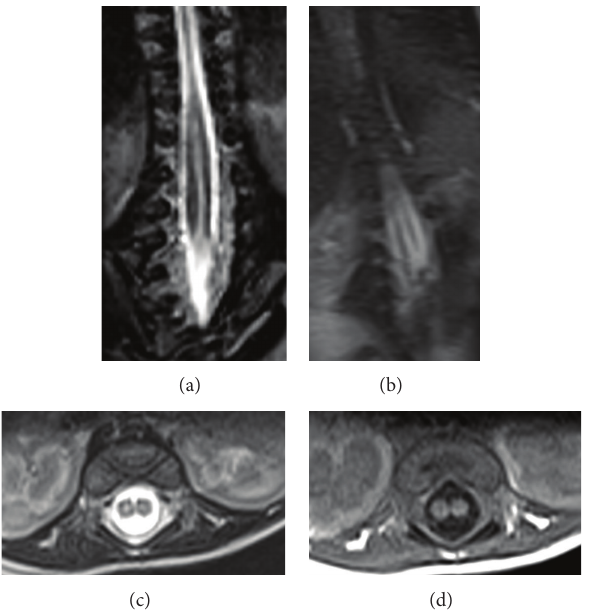
Figure 3: T2 coronal (a and b), T2 axial (c), and T1 axial (d) for spines demonstrating the spitted cord (diastematomyelia).